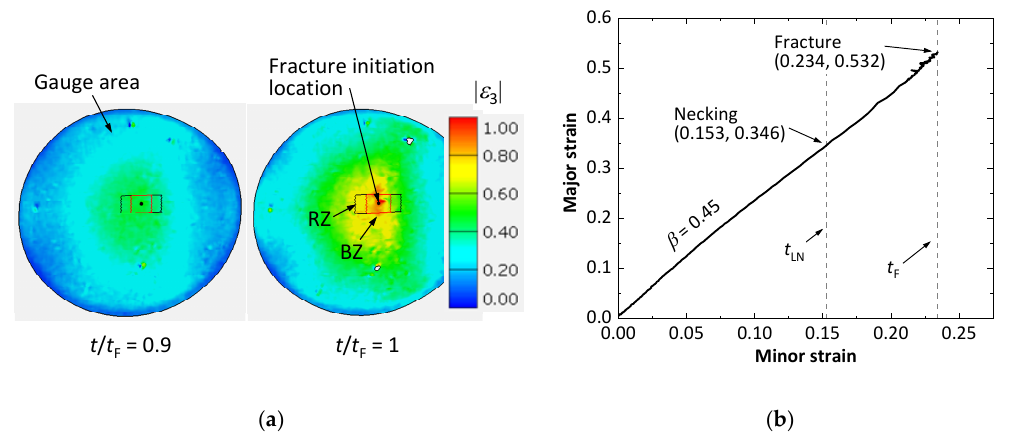
Figure 7. Cruciform specimen of boron steel deformed in biaxial tension at 800 °C and 0.1 /s [7]: ( a ) strain distributions in the gauge area at different normalized times; ( b ) strain path in the BZ, along with the necking and fracture limit strains (BZ: base zone, RZ: reference zone).